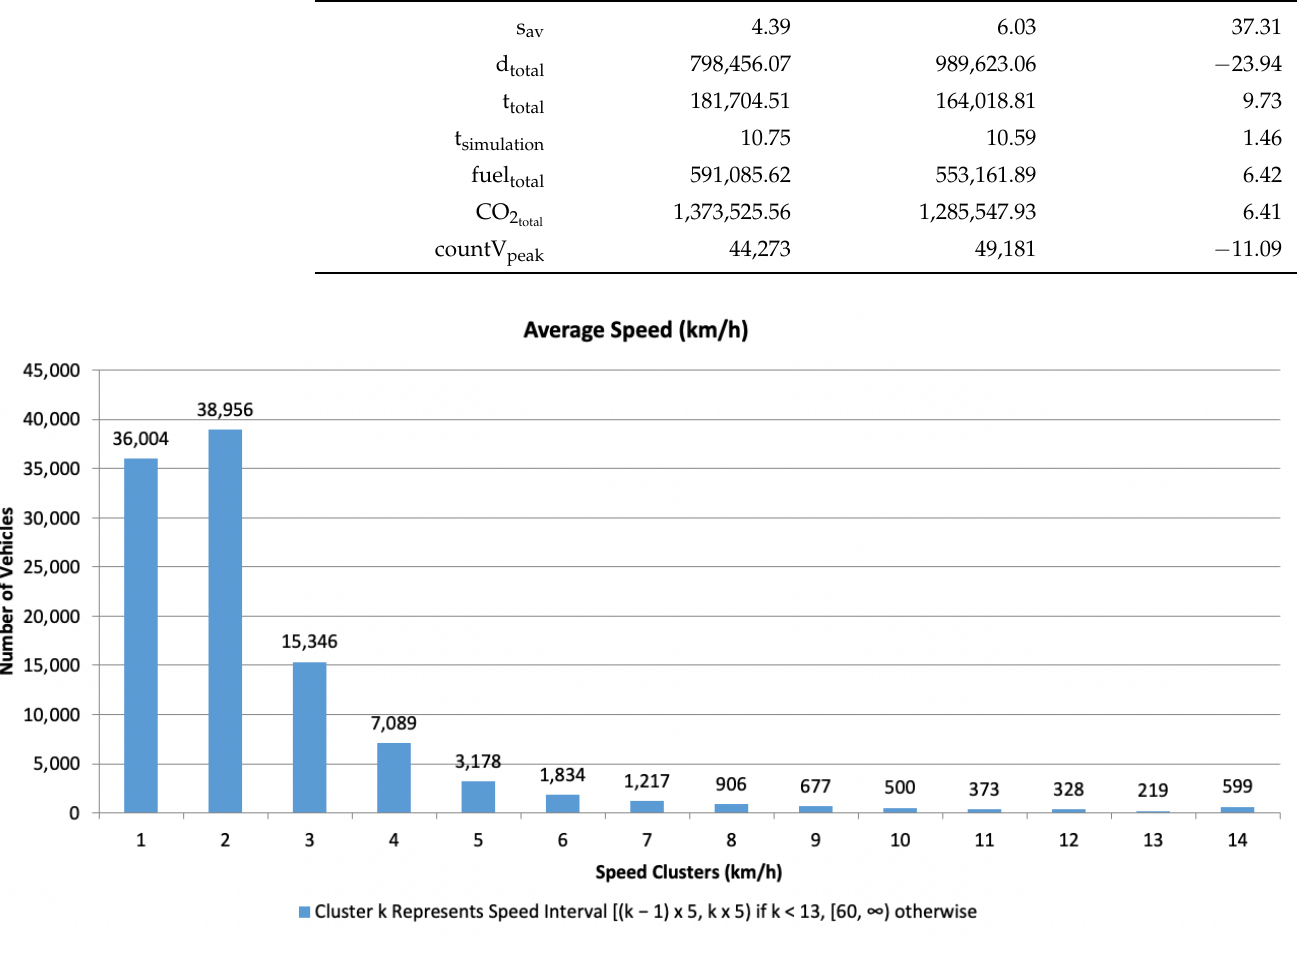
Figure 10. Speed distribution in clusters for 100 K+ simulated vehicles in New York with δ = 5. Table 12. Results and improvement of the proposed solution for 100 K+ simulated vehicles in